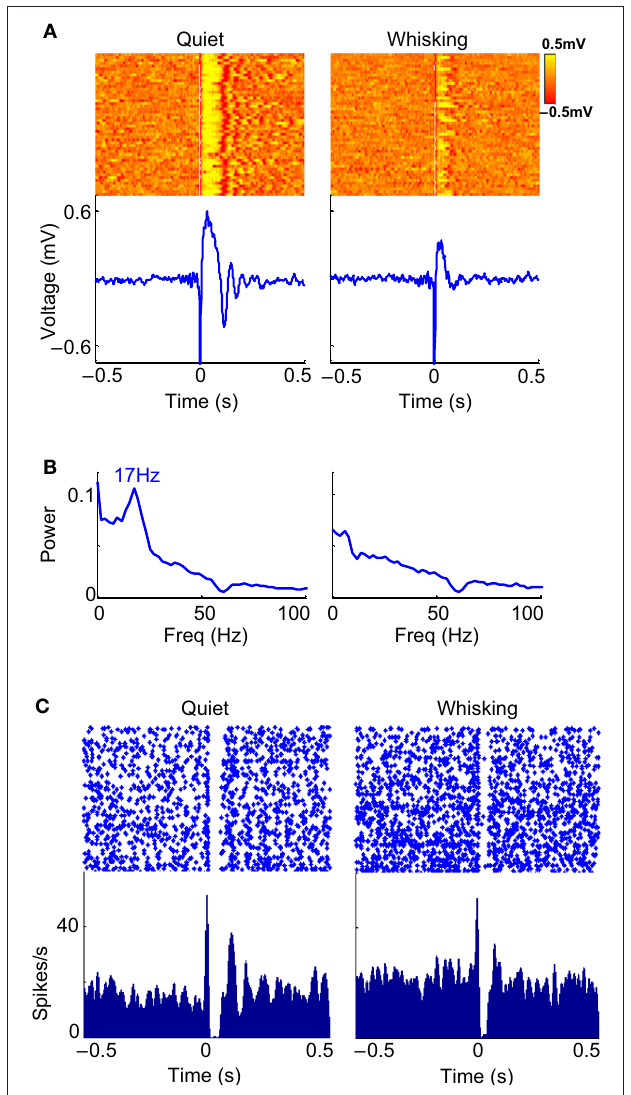
FIGURE 3 | LFP and multiunit evoked responses. (A) Raster plot and average evoked LFP responses to cortical microstimulation (at 0 s) in ‘whisking’ and ‘quiet’ trials. (B) The average power spectral density of the LFP during the period 100–500 ms after microstimulation in whisking and quiet trials. (C) Raster and histogram of evoked multiunit responses to microstimulation during whisking and quiet trials. The quiet trials show a lower baseline fi ring rate, a prolonged inhibition and oscillatory bursting but the initial excitation (0–5 ms) is similar to that observed when whisking.